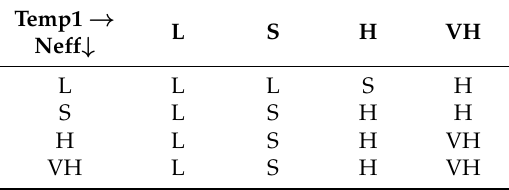
Table 2. Composition of temp1 and neff producing opt-performance.